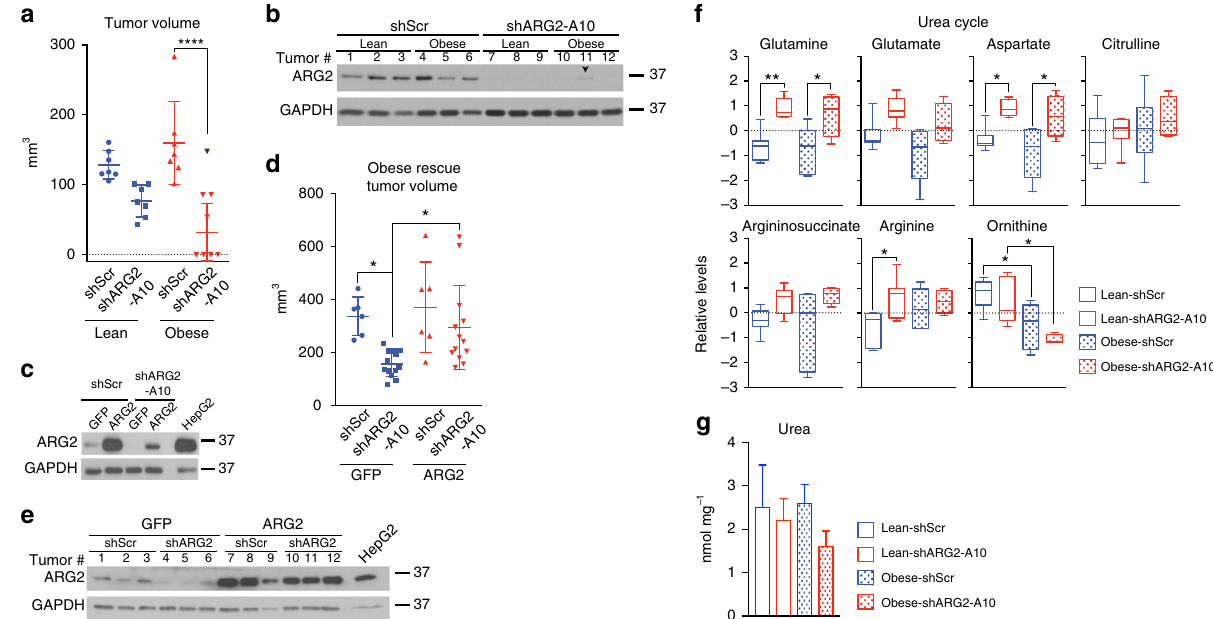
Fig. 3 ARG2 is essential for human PDA growth particularly in the obese. a Volumes of orthotopic PDA tumors derived from AsPC1-shScr and AspC1- shARG2 cells, injected (10 5 cells) into lean or obese 12 – 14 week old male Rag1 − / − mice and grown for 6 weeks ( n = 7 except for obese-shARG2, n = 8). The black data point indicates an outlier AspC1-shARG2 tumor not included in the statistics, due to re-expression of ARG2. b Immunoblots for ARG2 in tumors from a . Arrowhead indicates outlier in a . c Immunoblots for ARG2 in AsPC1-shScr and AsPC1-shARG2 cells expressing GFP or shRNA-resistant human ARG2. d Volumes of orthotopic PDA tumors from cells in c , grown in obese 27-week old male Rag1 − / − mice for 4 weeks (500,000 cells per mouse, n = 6 for shScr groups and n = 13 for shARG2 groups). Data represent two independent experiments. e Immunoblots for ARG2 from tumors in d . f Relative metabolite levels in PDA tumors from a ( n = 7, except for Obese-shARG2, n = 4). Box plots represent medians ± 10-90 percentile. g Urea levels in tumors from f measured by urea assay kit. In a , d , g , data indicate the mean ± s.d. * P ≤ 0.05, ** P ≤ 0.01, **** P ≤ 0.0001, by one-way ANOVA followed by Tukey test in a , d ,